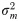
Unimodal model comparison.The unimodal analysis confirms previous results: overall B-R with sampling wins the model comparison. (A) Differences in log likelihood on unimodal data, averaged over participants. Negative values mean that B-R wins. ML-R is omitted because its poor performance complicates visualisation. (A) B-R wins at σg = 0.03 and σπ = 0.5, but not in the other conditions. (B) All models use the quadratic loss function to select responses, with response variance given by the motor noise σm2. B-R with sampling explains the unimodal data best for most participants. High subject-level variability results in large errors (see S1 Text for a subject-level analysis). (C, D) The fraction of participants best described by a given model. At σg = 0.4, several models perform well. Error bars indicate SEM across participants.